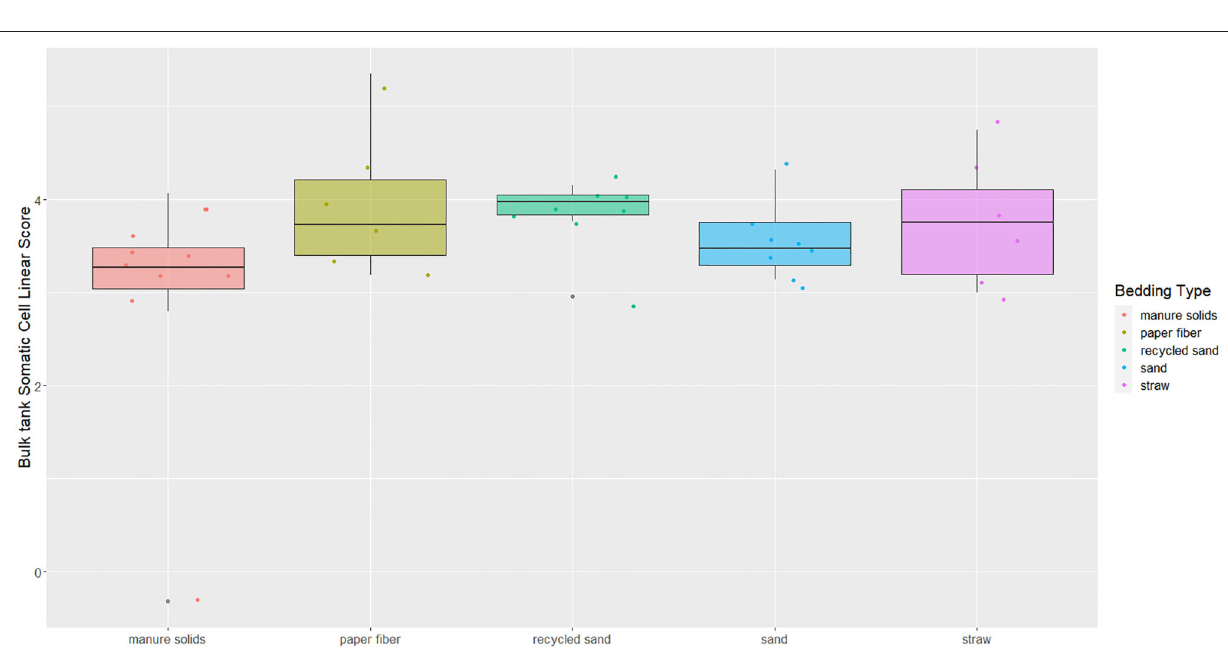
FIGURE 9 | Boxplots showing 25th, 50th (median), and 75th percentiles of somatic cell score in milk samples monthly collected (unless milk had been picked up prior to arrival for follow up visit) from the BT after mechanically agitating the milk for at least 5min until sufficient homogeneity is obtained from five conveniently